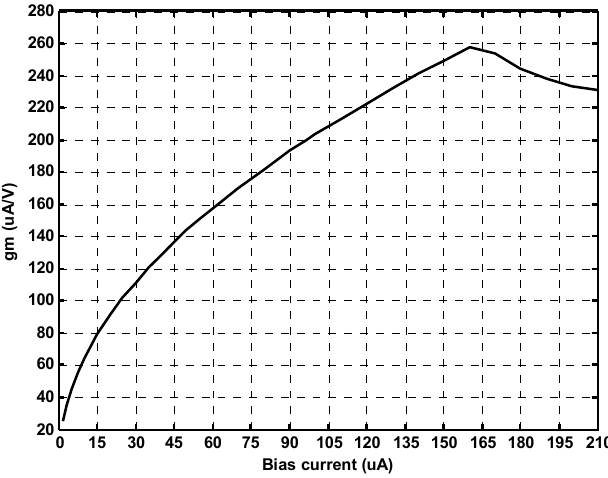
Figure 6. Variation of transconductance with bias current.